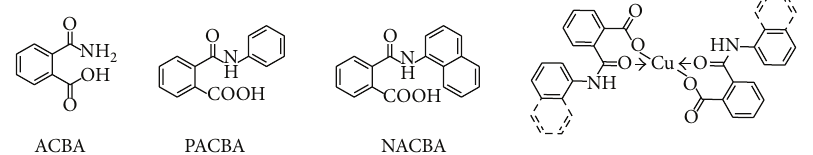
Figure 1: Carbamoybenzoic acids as monotopic ligands in organometallic complexes.